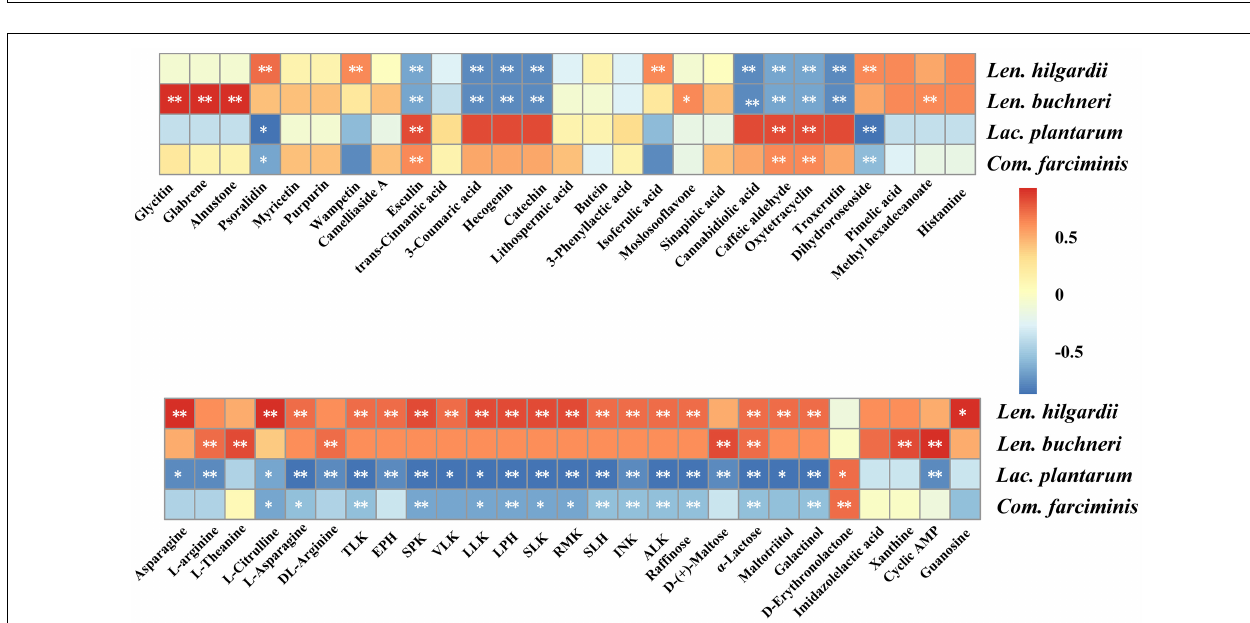
FIGURE 4 | Redundancy analysis (RDA) plot showing the correlations between fermentation (A) and nutrition (B) characteristics and the bacterial community. The orange arrow line represents fermentation and nutrition characteristics. The blue arrow line represents bacteria at the genus level. The angle between the orange arrow line and blue represents the correlation. The angle ≤ 90 ◦ represents a positive correlation, otherwise negative. The length of the arrow line represents the contribution of a factor to the bacterial community. The longer the line is, the greater the contribution is.